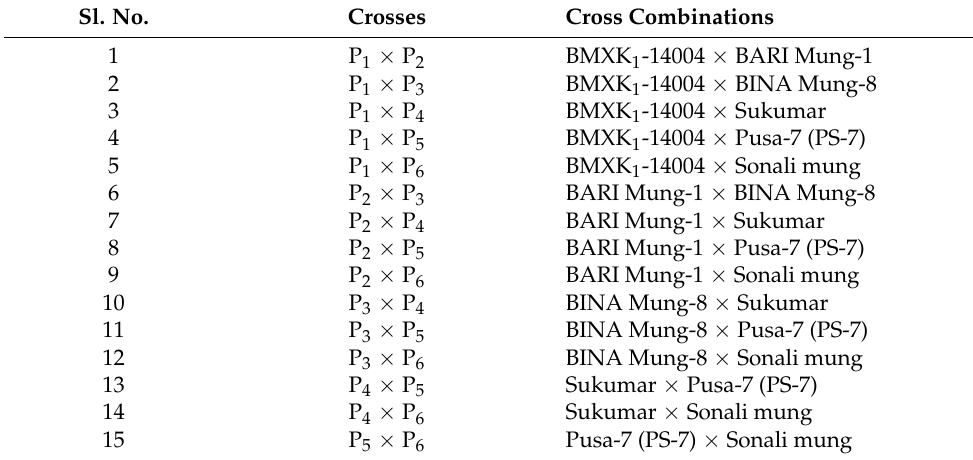
Table 7. Parents, pedigree, sources utilized in the investigation materials, and their exceptional highlights.